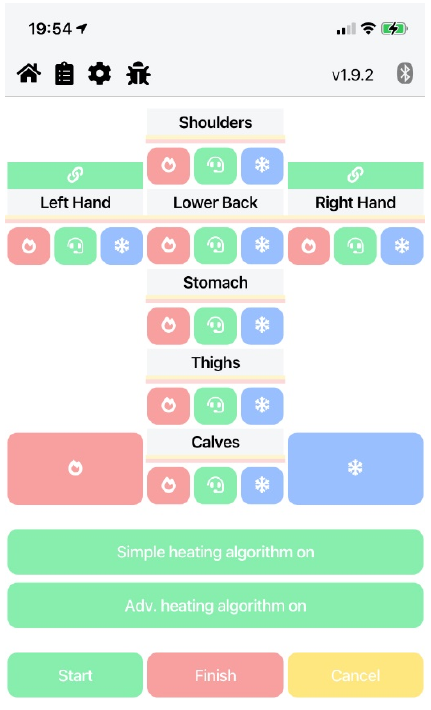
Figure 5. Mobile application GUI.